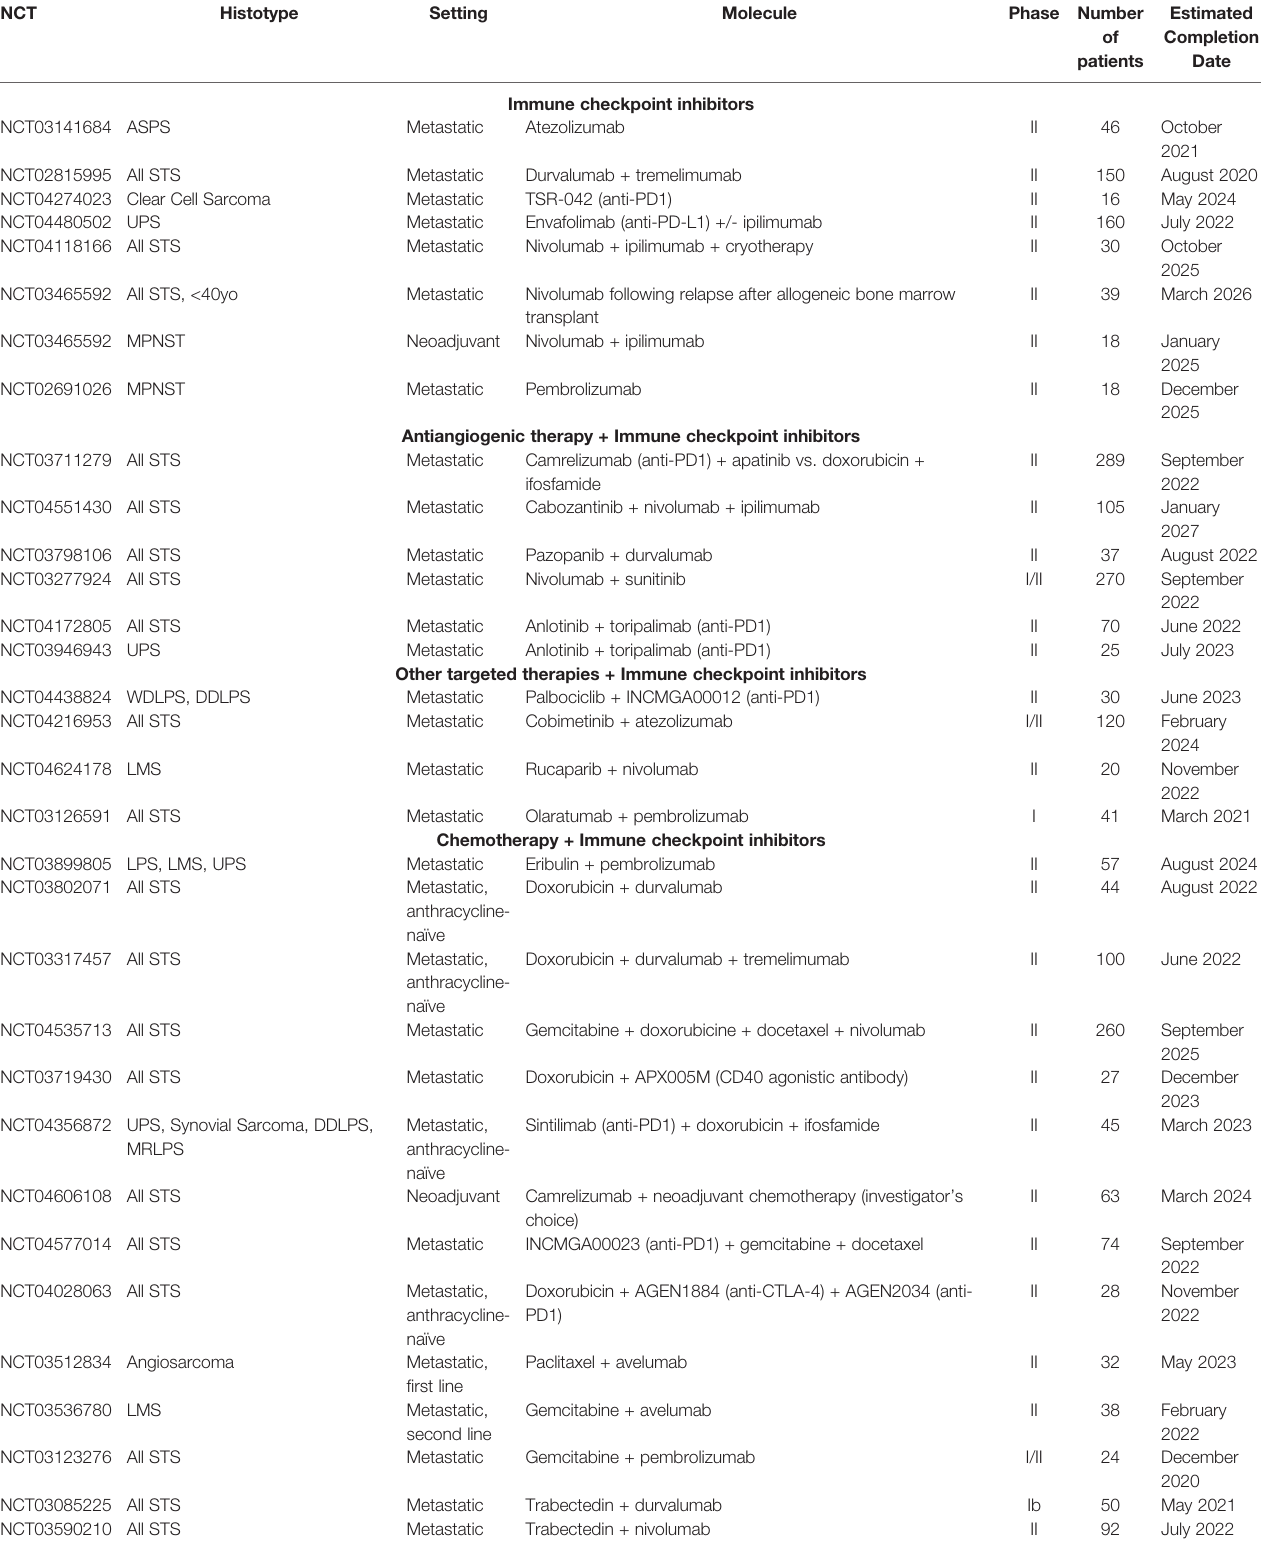
TABLE 3 | Ongoing clinical trials of immunotherapy in